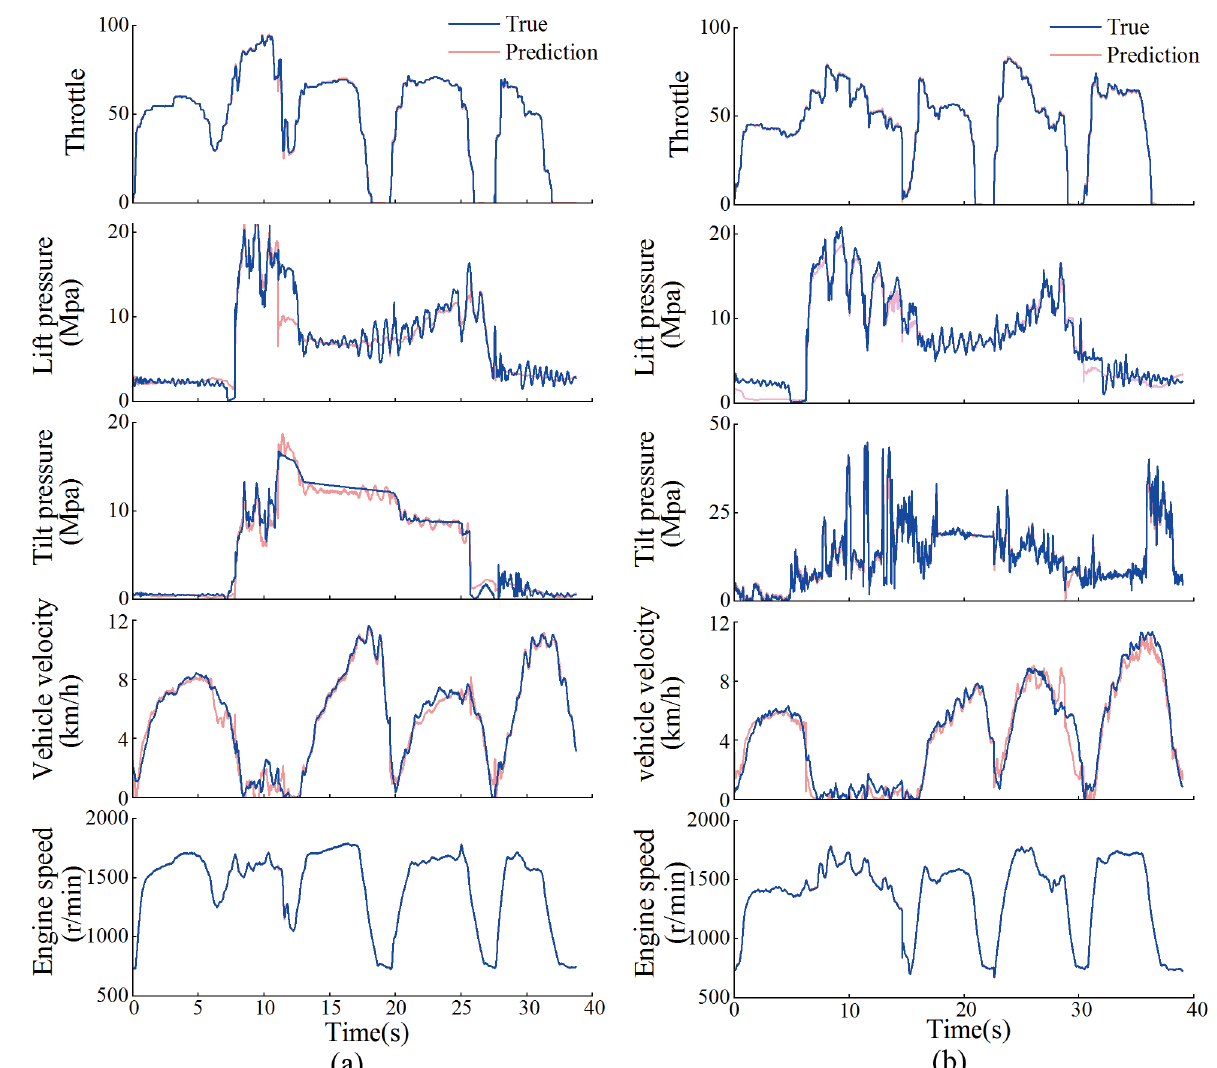
Figure 9. Driving data of experienced drivers and the predicted value from different materials: ( a ) small coarse gravel ( b ) large coarse gravel.